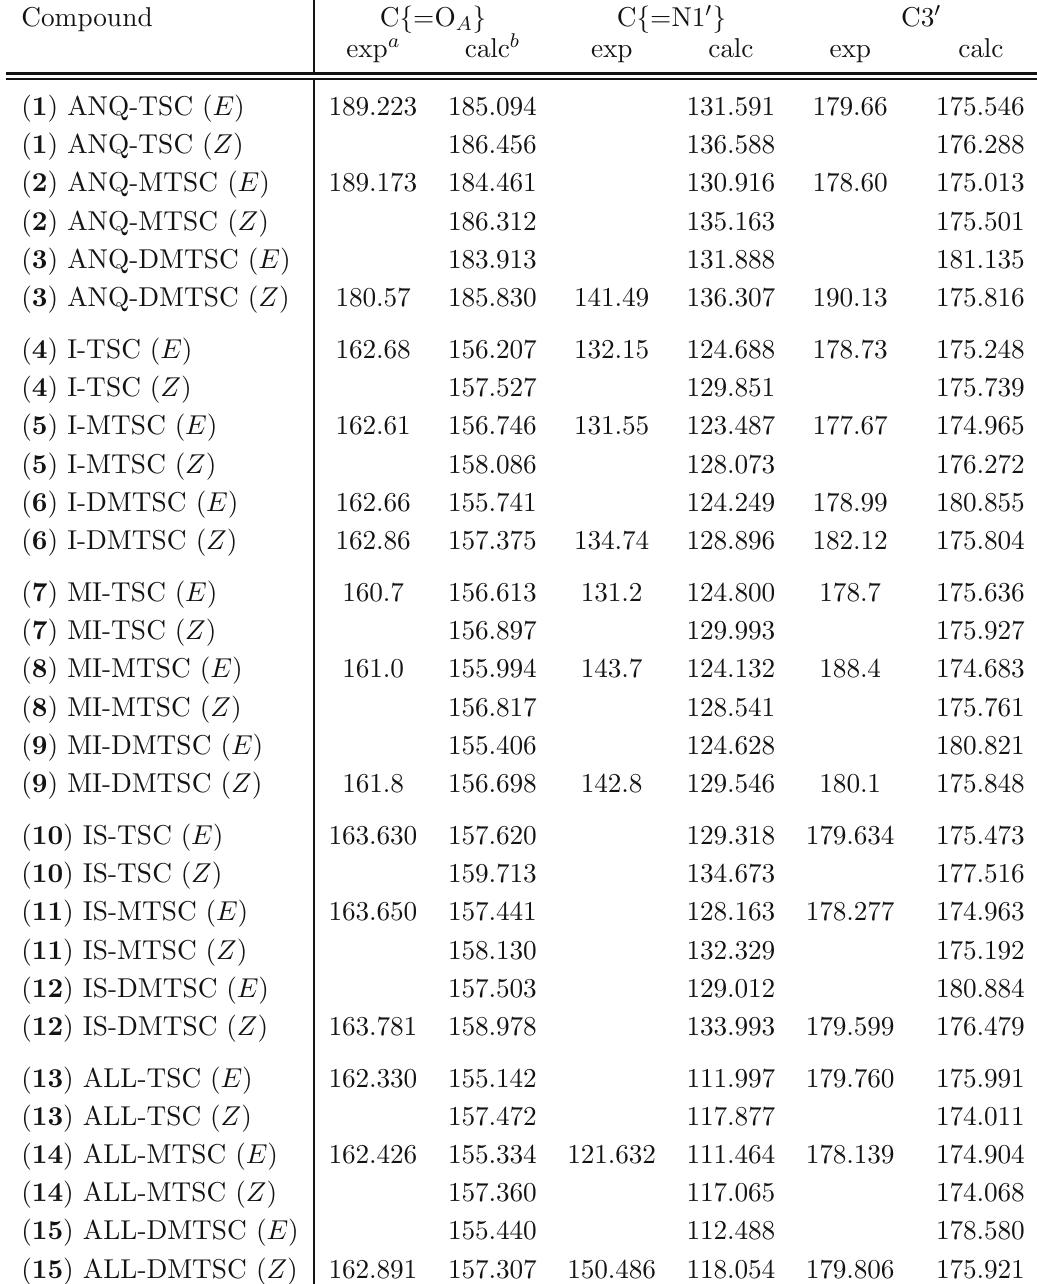
Table 4 Experimental and calculated 13 C NMR chemical shifts (ppm) a